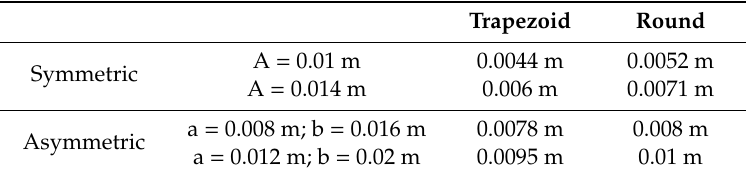
Table 3. The distance from side chamber to neutral